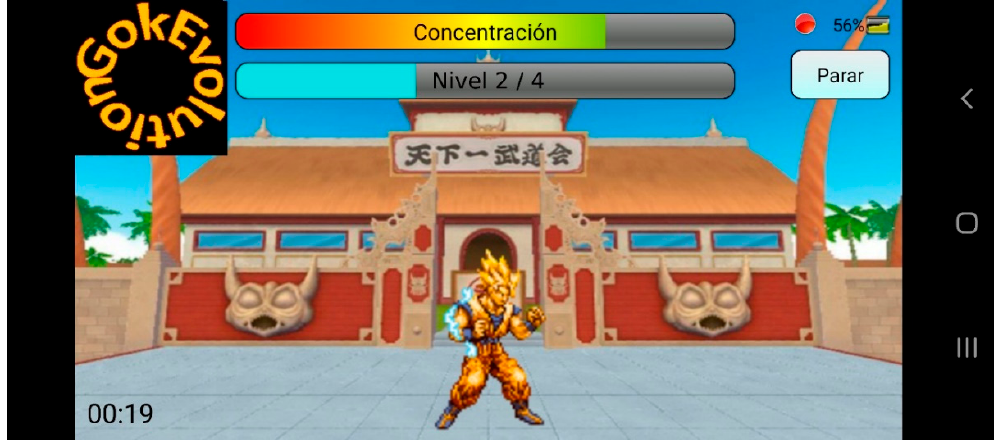
Figure 1. Screenshot of the GokEvolution application. The bars at the top indicate the level of attention recorded by the NeuroSky using the EEG sensor (top) and the achievement on the current level (bottom). The figure represents the character at level 2 (out of 4). If the attention level is higher than 50%, the character is “recharging energy” and the progress on the level increases. When level progress reaches the maximum (the whole bar) the game increases the level, changing the appearance of the character.